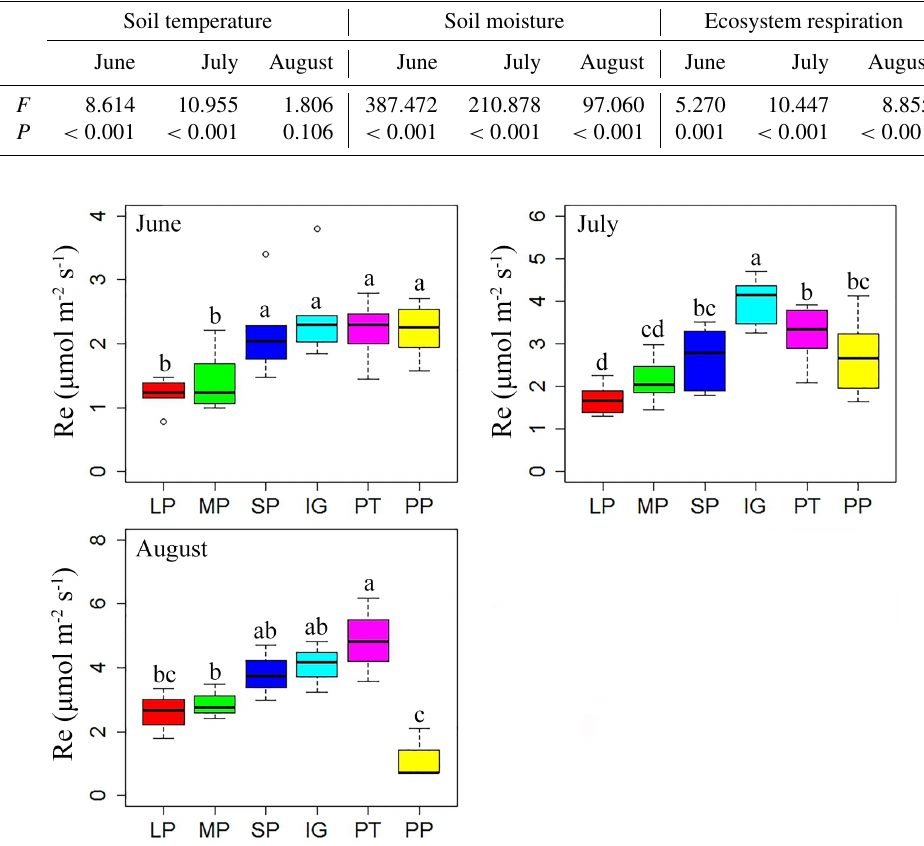
Figure 2. Ecosystem respiration of different surface types: (1) large bald patch (LP), (2) medium bald patch (MP), (3) small bald patch (SP), (4) intact grassland patch (IG), (5) above pika tunnel (PT) and (6) old pika pile (PP). The upper solid lines, the bottom solid lines, the bold solid horizontal line and the empty dot are the maximum value, minimum value, median and abnormal value, respectively. Letters on the error bars indicate significant differences among different surface types at P < 0 . 05.